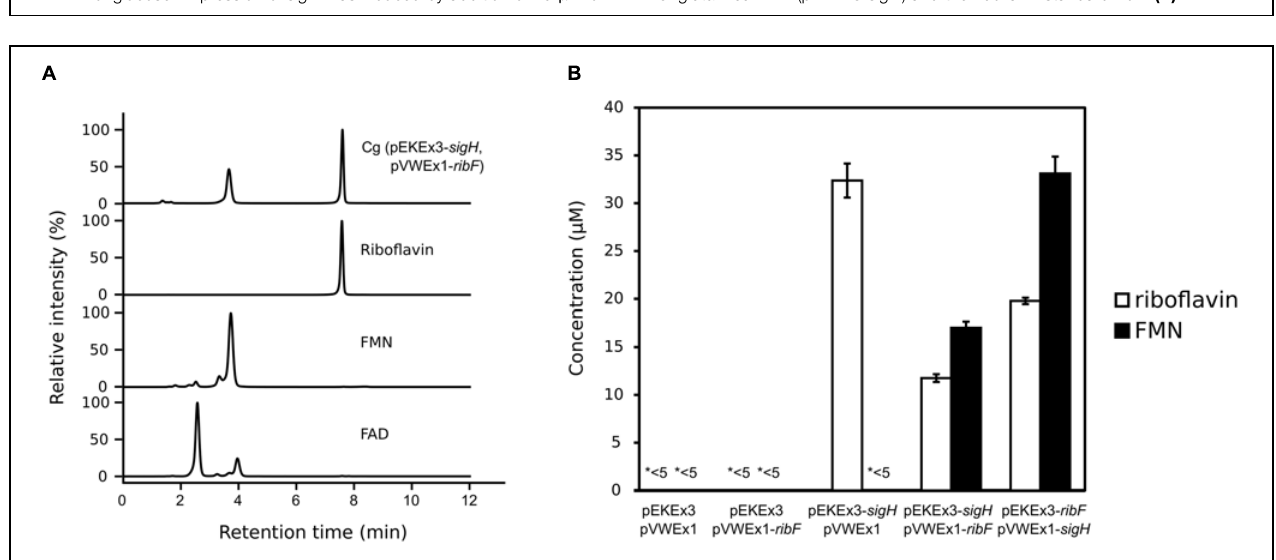
FIGURE 3 | Analysis of supernatants of C. glutamicum WT(pEKEx3- sigH ) cultures by (A) high performance liquid chromatography (HPLC) and (B) spectrophotometry. (A) HPLC chromatograms of supernatants of C. glutamicum WT(pEKEx3) and WT(pEKEx3- sigH ) after 48 h in CGXII with 222 mM of glucose. Expression of sigH was induced by addition of 15 μ M of